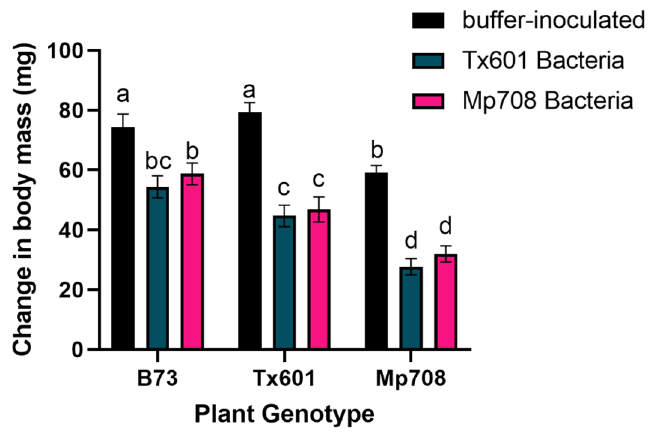
Figure 5. Effects of fecal transfer on recipient fall armyworm growth when fed on different maize genotypes. Different letters represent statistically significant differences (p < 0.05). Supplemental Figure 1: Non-metric multidimensional scaling of fall armyworm fed corn from the field using Bray–Curtis (A) and Jaccard (B) dissimilarities. Frass is included to compare with the guts of insects feeding on Tx601 and Mp708 foliage. Proportion of OTUs (C) and a heatmap (D) of OTUs illustrating the different assemblages produced by the frass compared to the gut